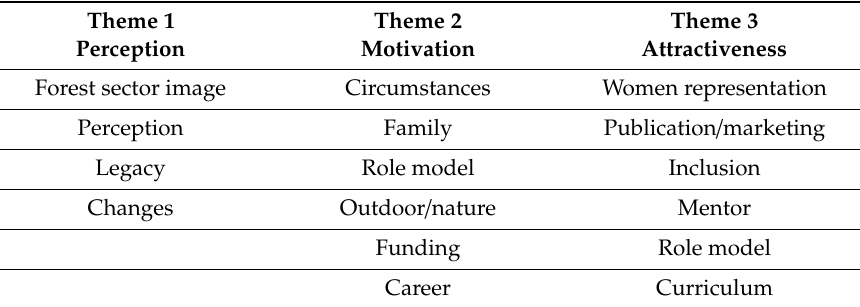
Table 1. Themes and